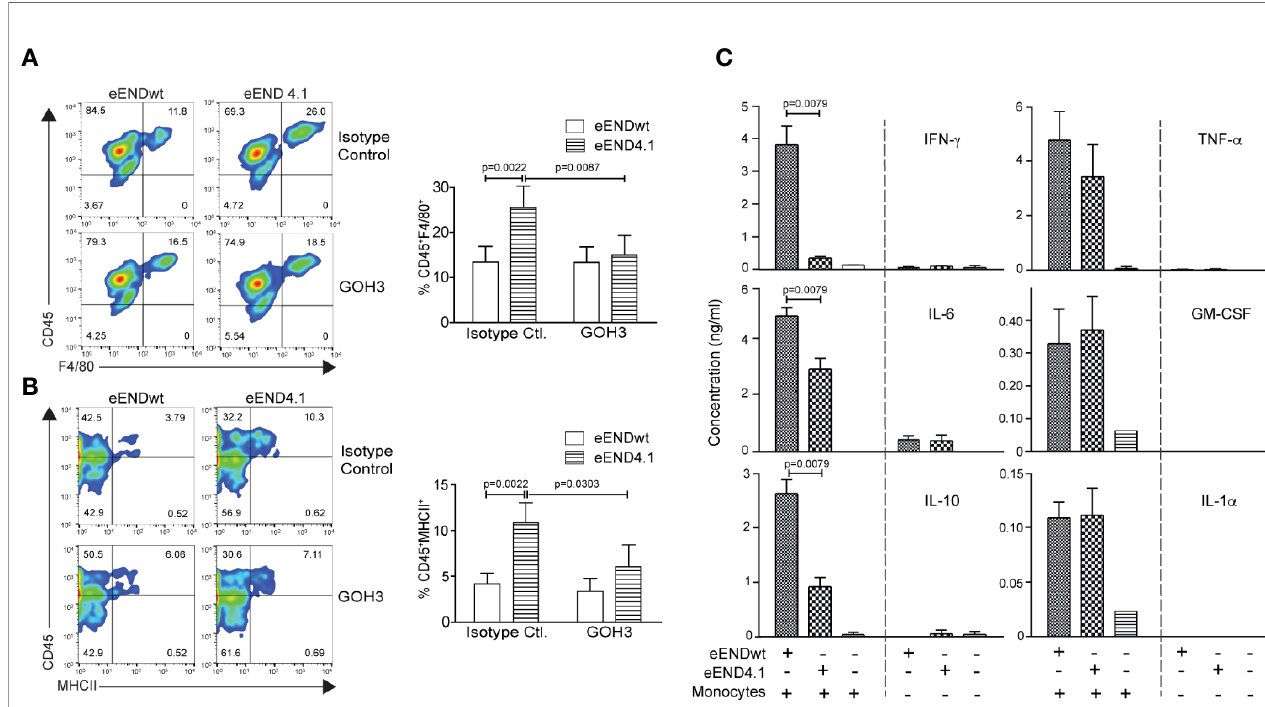
FIGURE 5 | Enhanced in vitro differentiation of splenic monocytes to macrophages on laminin 511-overexpressing endothelial cells. Representative fl ow cytometry for (A) CD45 + F4/80 + and (B) CD45 + MHCII + in splenic monocytes cocultured for 16 h with eENDwt or eEND4.1 cells in the presence or absence of integrin a 6 blocking (GoH3) antibody; bar graphs show quanti fi cation of the data expressed as a percent of the total CD45 + population. Isotype control antibody had no effect. Data are means ± SD from three experiments with two replicates/experiment/treatment. Signi fi cance was calculated using a Mann-Whitney test; exact p -values are shown in the graph. (C) Cytokine concentrations in conditioned media of eENDwt or eEND4.1 cells cultured in the presence or absence of splenic monocytes for 16 h, and of splenic monocytes alone. Data are means ± SD of 3 experiments performed with duplicates/experiment. Absence of values indicates that the cytokines were not detectable. Signi fi cance was calculated using a Mann-Whitney test; exact p -values are shown in the